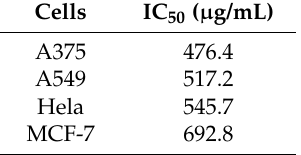
Table 1. IC 50 of different cells exposed to curcumin/ β -cyclodextrin polymer inclusion complex for 72 h. Cells